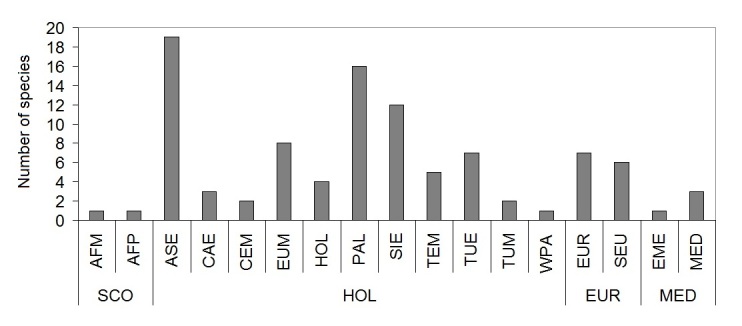
Chorotypes of ground beetles collected in the study area during 2009 and 2010 (AFM = Afrotropical-Mediterranean, AFP = Afrotropical and Paleartic, ASE = Asiatic-European, CAE = Central Asiatic-European, CEM = Central Asiatic-European-Mediterranean, EME = E-Mediterranean, EUM = European-Mediterranean, EUR = European, MED = Mediterranean, HOL = Holoartic, PAL = Paleartic, SCO = Subcosmopolitan, SEU = S-European, SIE = Siberic-European, TEM = Turanic-European-Mediterranean, TUE = Turanic-European, TUM = Turanic-Mediterranean, WPA = W-Paleartic) (plotted after data in Table 1).